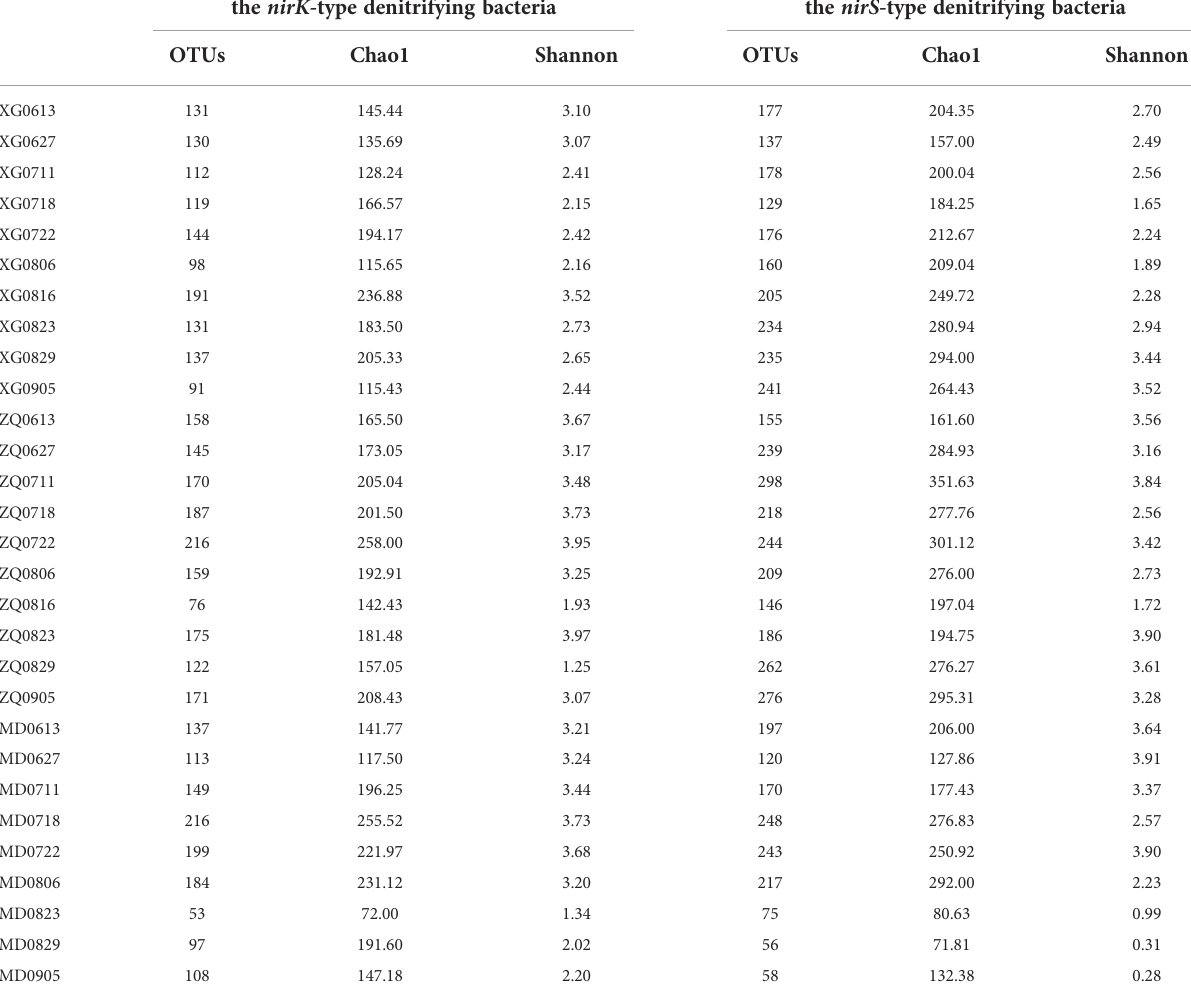
TABLE 1 Alpha-diversity of the nirK -type and nirS -type denitrifying bacterial communities during the green tide in Qingdao coastal